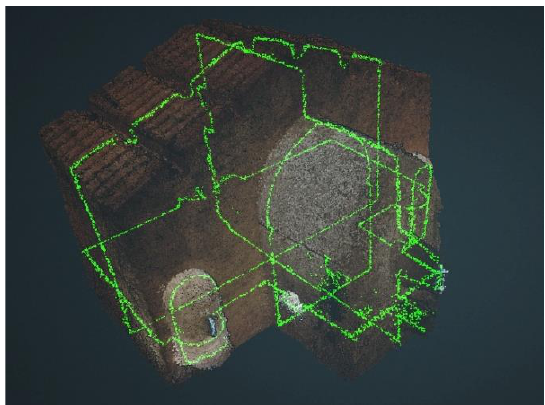
Figure 7 : Visualisation of the laser levels’